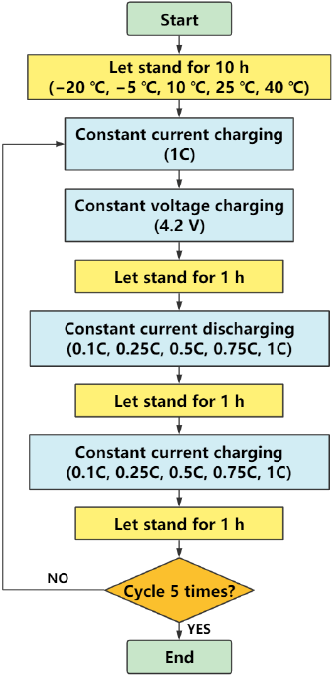
Figure 2. The test process.